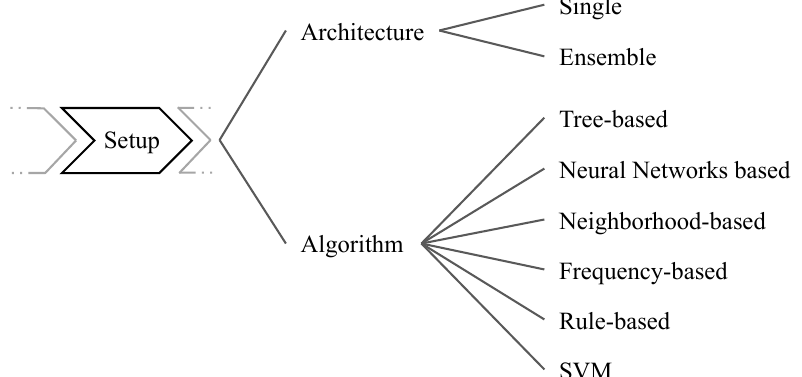
Figure 6. Overview of classification algorithms. Depending on the data sources and initial processing , the choice of a suitable algorithm has to